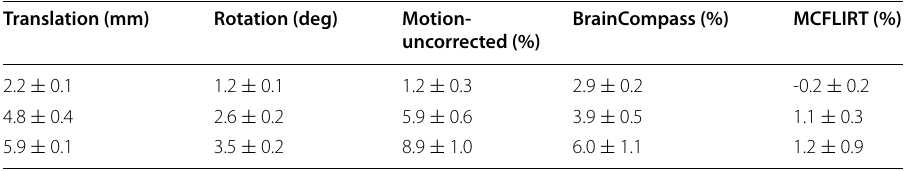
Table 2 Volume increase (including SD) of MoCo methods for an increasing angle of rotation compared to the motion-uncorrected volume